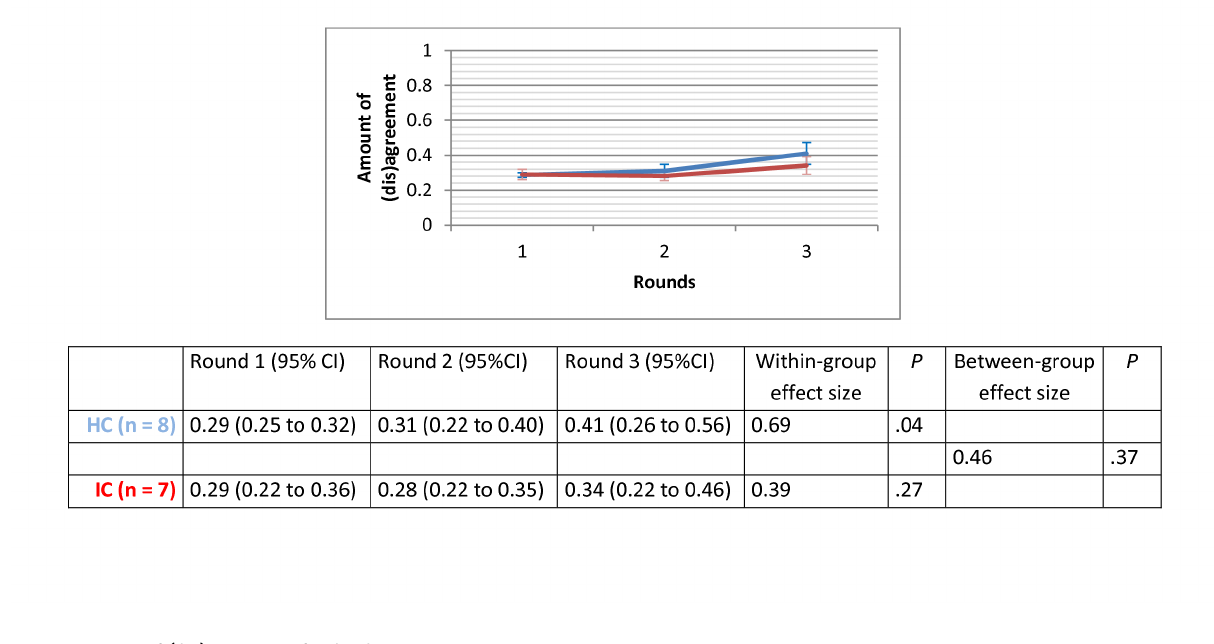
Figure 6. Amount of (dis)agreement for the therapeutic options